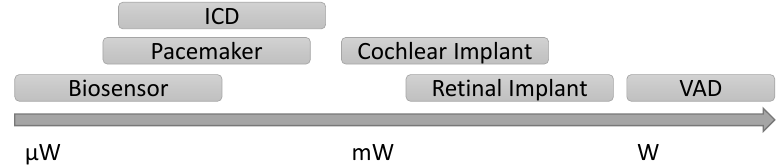
Figure 1. Range of power requirements of example implantable medical